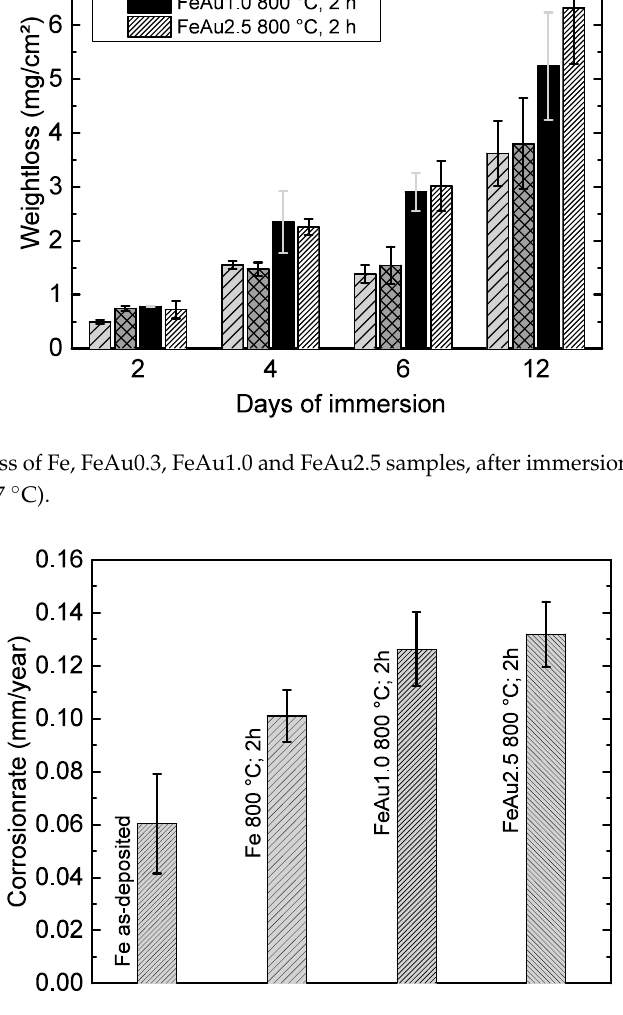
Figure 5. Mean corrosion rate of Fe, FeAu1.0 and FeAu2.5 samples. Using Equation (1), the corrosion rates were calculated from the corrosion current density j c , determined linear polarization in HBSS (pH 7.4; 37 °C) and Tafel extrapolation method.